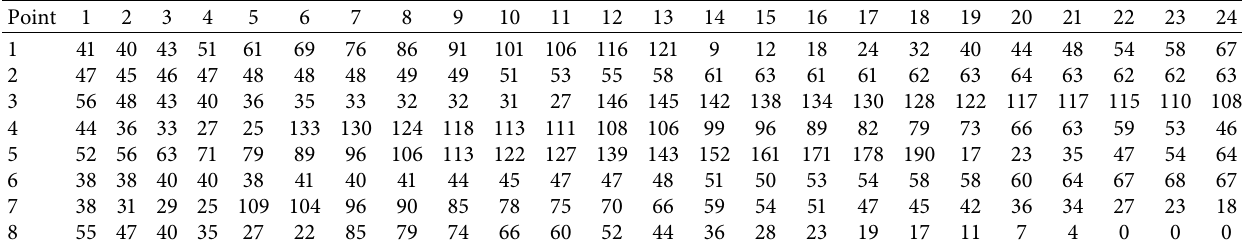
Figure 5: Pareto frontier. Table 4: Numbers of bikes for each period in the optimal scheduling